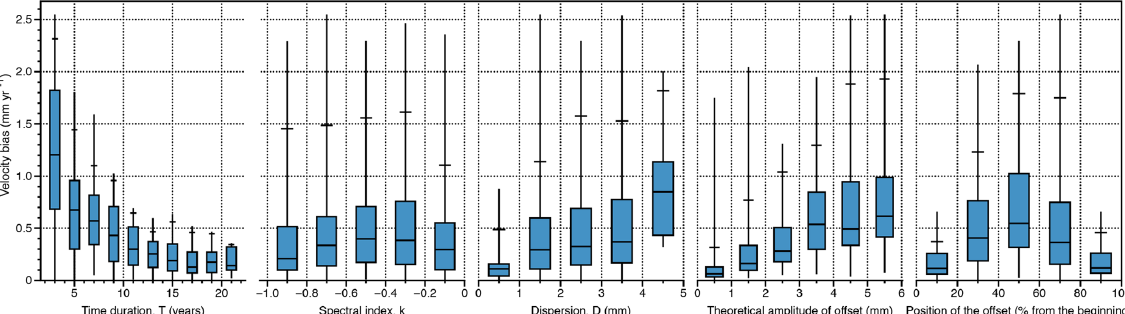
Figure 6. Whisker plots of velocity bias as a function of the duration ( T ), spectral index ( k ), dispersion ( D ), offset amplitude (amp off ), and offset position in percentage for series with only 1 offset unresolved. The horizontal top bar represents v 95 .